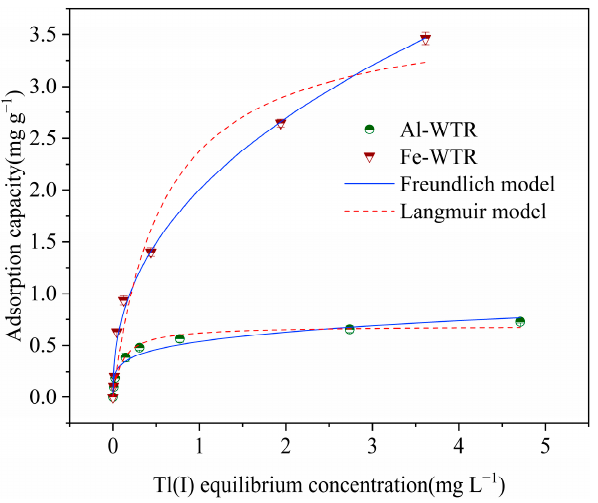
Figure 2. Isothermal adsorption model of Fe-WTR and Al-WTR for Tl(I). Table 3. Isothermal adsorption model parameters of Fe-WTR and Al-WTR for Tl(I).